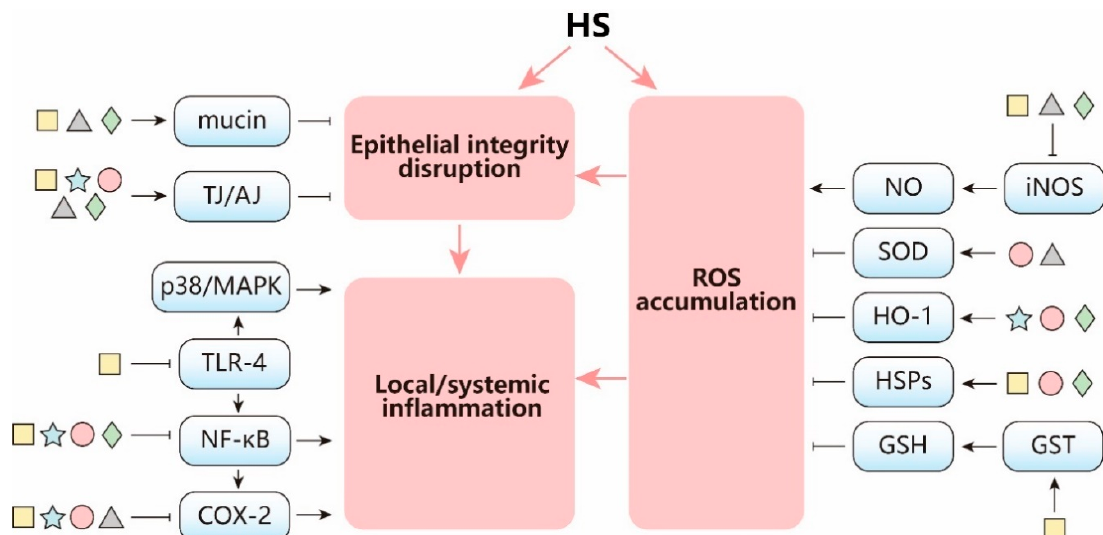
Figure 3. The pathways behind the protective effects of nutritional supplementation on HS-induced intestinal integrity disruption, inflammation, and oxidative stress. Pre-/probiotics (yellow square ⬜ ), α -lipoic acid (blue star ⭐ ), resveratrol (red circle ⚪ ), DHA/EPA (grey triangle 🔺 ) and amino acids (green diamond 🔷 ) not only restore intestinal epithelial integrity by increasing TJ/AJ protein and mucin expression, but also participate in anti-inflammation and stress resilience pathways. Normal arrow: enhancement or activation; bar-headed arrow: reduction or inhibition.